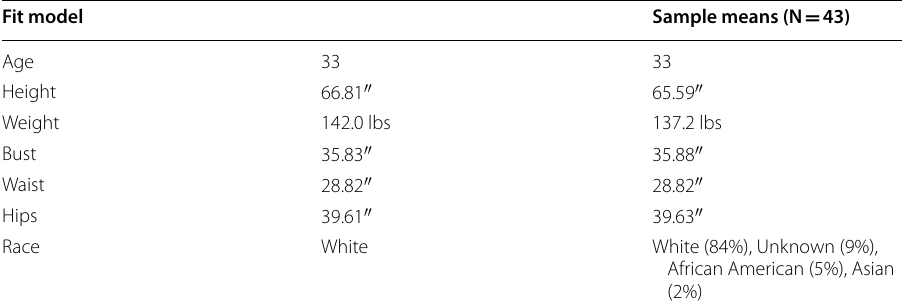
Table 1 Descriptive summary of chosen fit model and sample Fit model